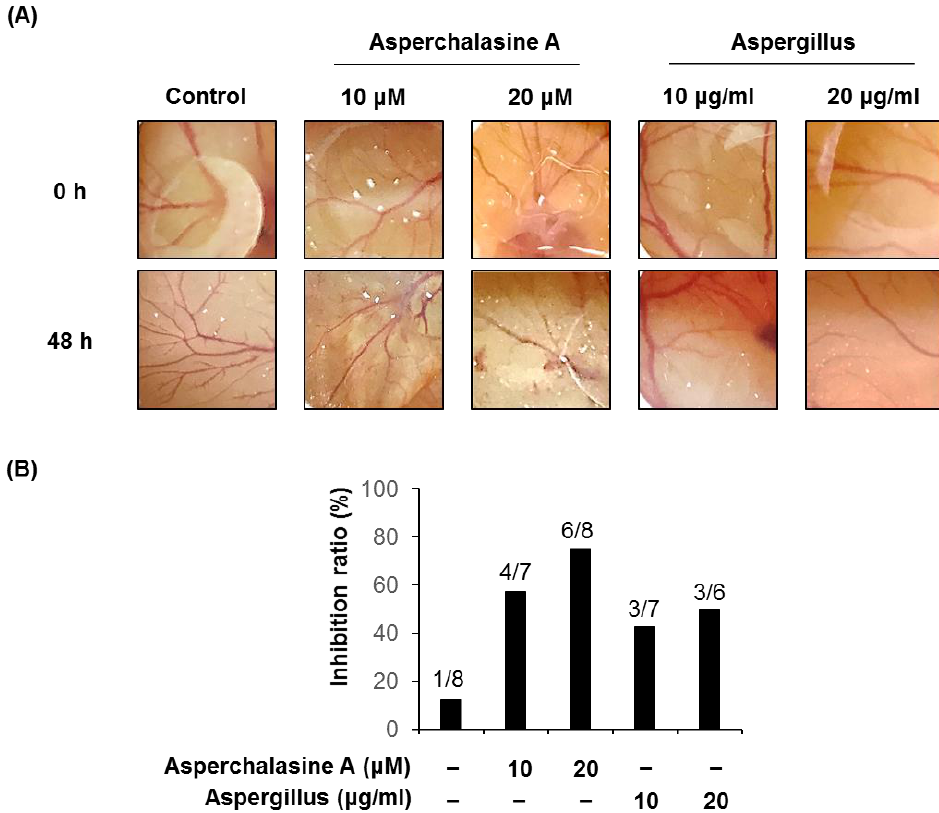
Figure 9. The in vivo anti-angiogenic effects of asperchalasine A and Aspergillus extract. ( A ) Images show representative blood vessel formation on the chorioallantoic membrane (CAM) following treatment with 10 and 20 μ M asperchalasine A or 10 and 20 μ g/mL Aspergillus extract for 48 h. ( B ) Calculations were based on the ratio of eggs with inhibited neovascularization relative to the total number of live eggs.